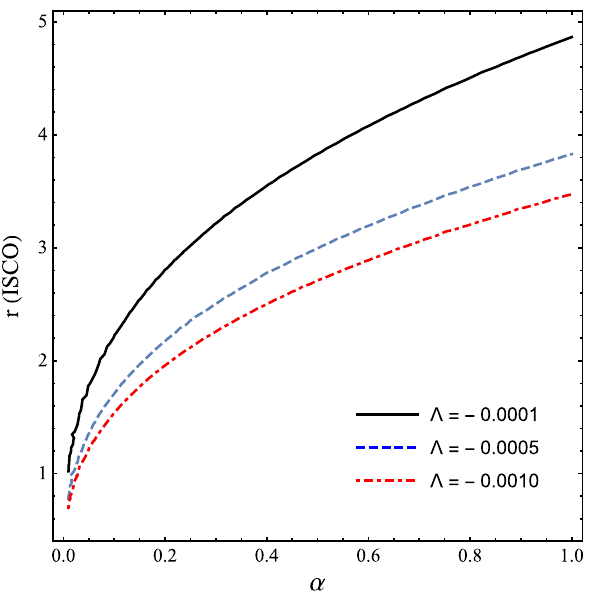
Fig. 3 The dependence of the ISCO radius on the GB parameter α for different values of cosmological constant (cid:4)